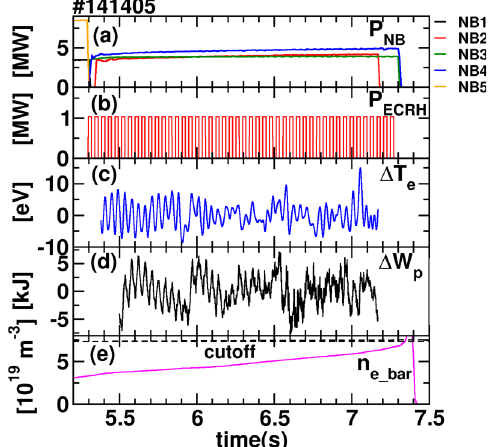
Fig.8 : Plots similar to Fig. 5. The electron density was ramped up. Differences of the ECE and the stored energy from their time trends were taken between 5.5 s to 7.17 s. when NB2